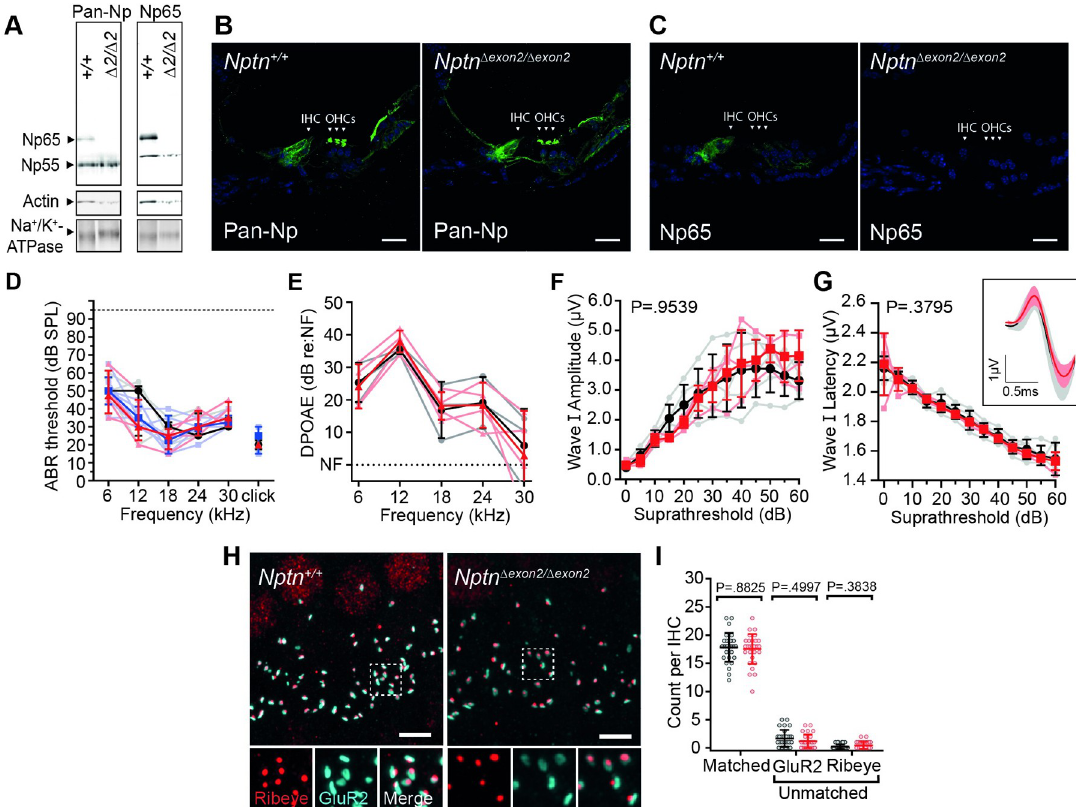
Fig 8. Np65 is not essential for hearing. (A) Western blot of membrane-enriched fractions from Nptn +/+ (+/+) and Nptn Δ exon2/ Δ exon2 ( Δ 2/ Δ 2 ) cochlear lysates. Lysates were treated with PNGase F to remove N-linked glycans prior to running. The anti-pan-Np antibody detects bands corresponding to Np65 and Np55 in the wild type membrane fraction and the anti-Np65-specific antibody detects a single band corresponding to Np65. No bands were detected in Nptn tm1b/tm1b lysates when using either antibody. Na + /K + -ATPase was used as a plasma membrane marker protein. (B) Immunohistochemistry using anti-pan-Np on cochlear cryosections showed labelling of outer hair cell (OHC) stereocilia, the inner hair cells (IHCs), and lateral support cells in both Nptn +/+ and Nptn Δ exon2/ Δ exon2 cochleae. Scale = 20 μ m. (C) the anti-Np65 specific antibody showed labelling of IHCs in Nptn +/+ cochleae. No signal was observed in Nptn Δ exon2/ Δ exon2 cochleae. Scale = 20 μ m. (D) ABR threshold measures of 1-month old mice. Nptn Δ exon2/ Δ exon2 (red triangle, n = 4) and Nptn +/ Δ exon2 (blue square, n = 6) mice have thresholds similar to Nptn +/+ littermate controls (black circle, n = 5) across all measured frequencies. Data are median ± IQR with individual data points shown. One-way ANOVA comparing against wild type controls with Dunnett’s correction for multiple comparisons. (E) Average DPOAE responses at 1-month of age showing no significant difference between Nptn Δ exon2/ Δ exon2 (n = 4) and littermate controls ( Nptn +/+ , n = 3). Data are mean ± SD with individual data points shown. One-way ANOVA comparing against wild type controls using Dunnett’s test for multiple comparisons. (F-G) Click-evoked ABR wave I measures comparing Nptn +/+ (black, n = 5) and Nptn Δ exon2/ Δ exon2 (red, n = 4) mice. Waveforms were not significantly different. Amplitude: P = 0.9539, Latency: P = 0.3795 (two-way ANOVA). Inset shows an average of wave I following click stimulus at 30 dB above threshold. Data are mean ± SD with individual data points shown. (H) Maximum intensity projections of mid-apical cochlear whole-mounts from Nptn Δ exon2 mice labelled with the pre-synaptic ribbon marker Ribeye (red) and post-synaptic density marker GluR2/3 (cyan). Insets show an enlarged 5 μ m x 5 μ m region highlighted by the dashed box in the above image. Scale bar = 5 μ m. (I) Ribeye and GluR2/3 puncta count from ten hair cells (two independent regions per mouse, three mice per genotype). Ribeye and GluR2/3 were considered matched when directly juxtaposed to one another. No significant difference was found in Nptn Δ exon2/ Δ exon2 cochleae. Data are mean ± SD with individual data points shown. Data compared against wild type controls using unpaired t-tests with a Holm-Sidak correction for multiple comparisons.